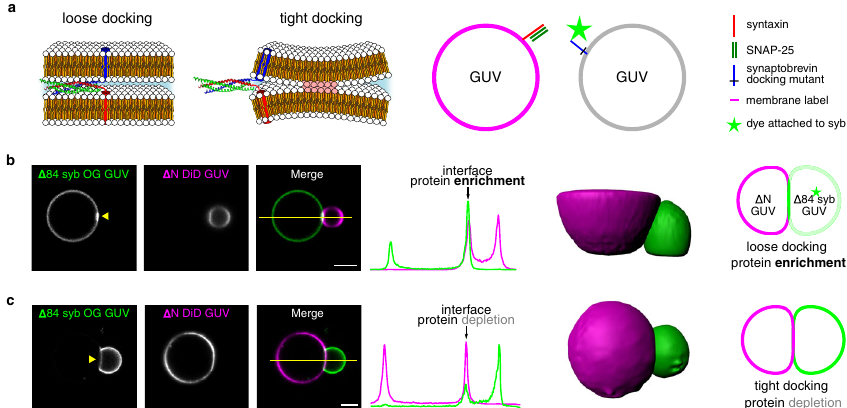
Fig. 1 Distribution of SNARE proteins at the docking interface differs between loose and tight docking states. a Schematic illustration showing loose and tight docking states (left) and the experimental system used in the docking experiments (right). One set of GUVs contain the lipidic membrane dye DiD (magenta) and unlabeled Q-SNARE complexes, whereas the other set of GUVs contains the synaptobrevin docking mutant Δ 84 syb, labeled with Oregon Green 488 (OG, green). SNARE complex structure PDB ID: 3IPD 39 . b , c Examples (from >5 independent experiments) of a loosely ( b ) and tightly ( c ) docked GUV pair, respectively, imaged by fl uorescence microscopy. The position of a line scan for fl uorescence intensities (graph next to images) is marked with a yellow line. Labeled synaptobrevin is enriched at the interface in the loosely docked state and depleted at the interface in the tightly docked state (see also schematic drawing on the right). Scale bars 5 μ m. Source data are provided as a Source Data fi